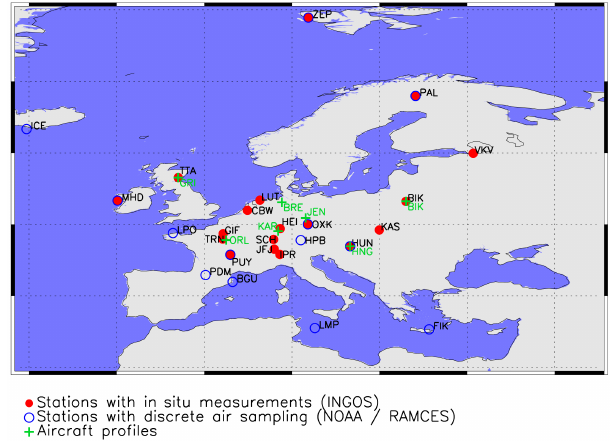
Figure 1. Map showing locations of InGOS atmospheric monitor- ing stations with in situ CH 4 measurements (filled red circles), ad- ditional stations with discrete air sampling (open blue circles), and the locations of the aircraft profiles (green